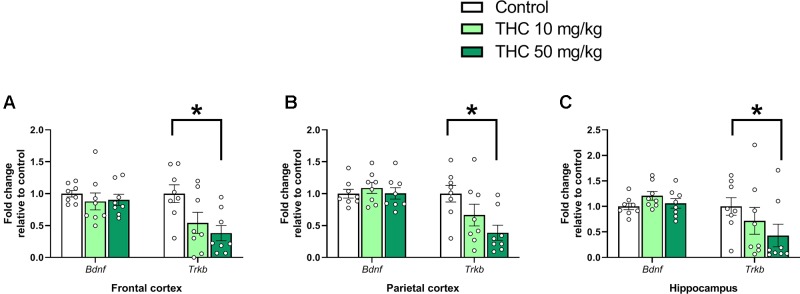
Neurotrophic gene markers. Transcript levels of neurotrophic genes Bdnf and Trkb 24 h after PND 10 exposure to vehicle, 10 mg THC/kg or 50 mg THC/kg in the (A) frontal cortex, (B) parietal cortex, and (C) hippocampus. Statistical difference from post hoc test is indicated as * if p < 0.05. Height of bars represents the mean fold change ± SEM of 8 mice.